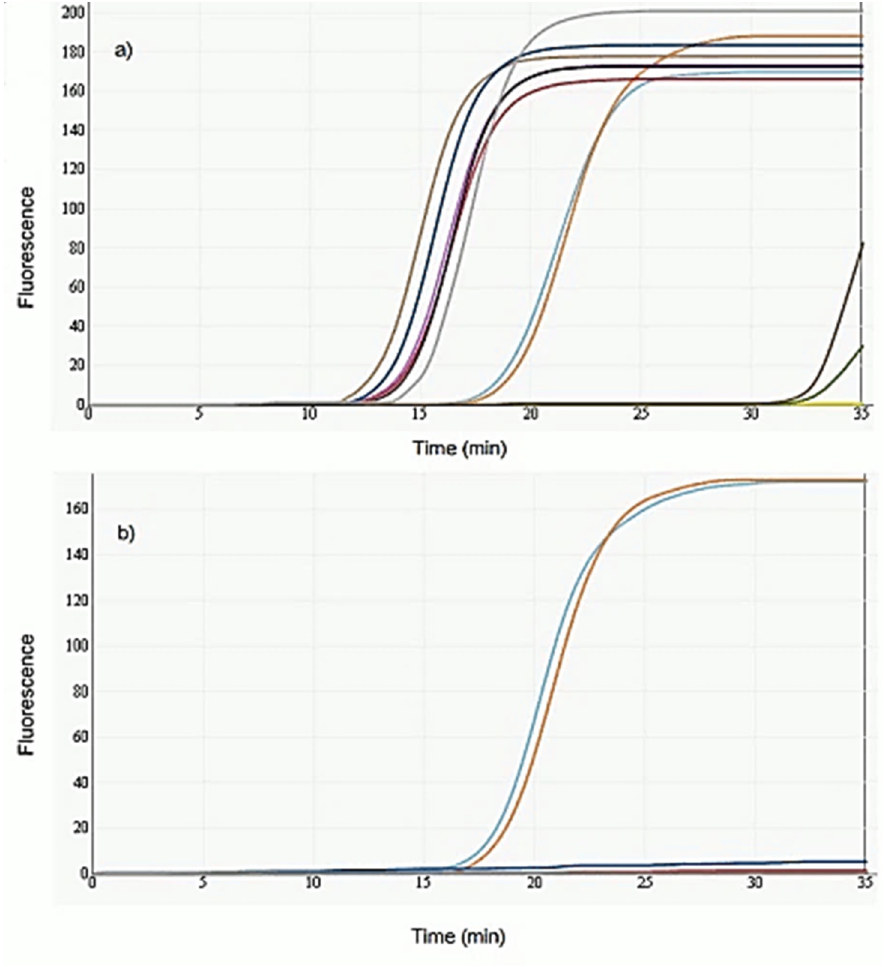
Figure 2. Monitoring of Loop-mediated isothermal amplification (LAMP) amplification for sensitivity ( a ) and specificity ( b ) tests from homogenized farmed salmon samples. The analysis shows the DNA amplification detection in real-time (colored curves shown in ( a ) and ( b )) by measuring the increasing fluorescence of DNA binding to the dye. The amplification plots displayed in the specificity correspond to the positive control (duplicate).